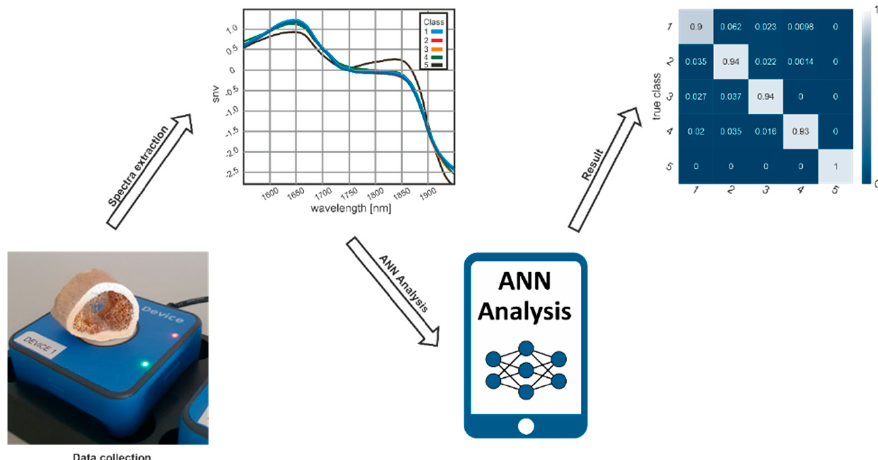
Figure 5. Workflow for NIR-based analysis of spectra. After a single data collection with the extraction of typical spectra, the spectra are analyzed by the ANN software to assign the predicted age class to the input data with high accuracy of almost 100%.